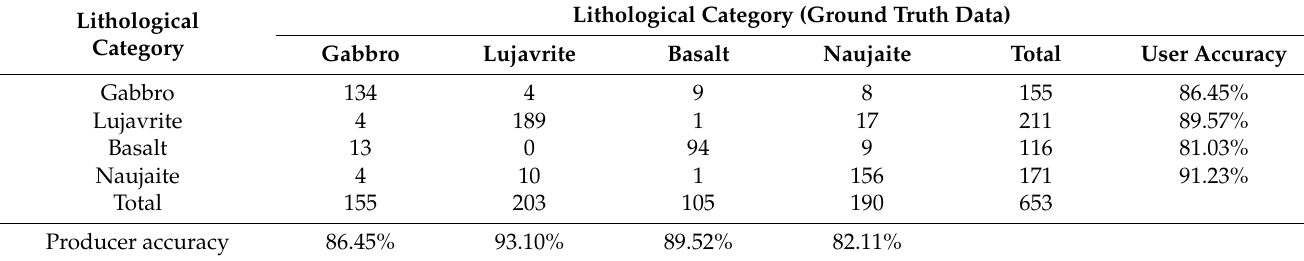
Table 4. Result accuracy evaluation table for classification using